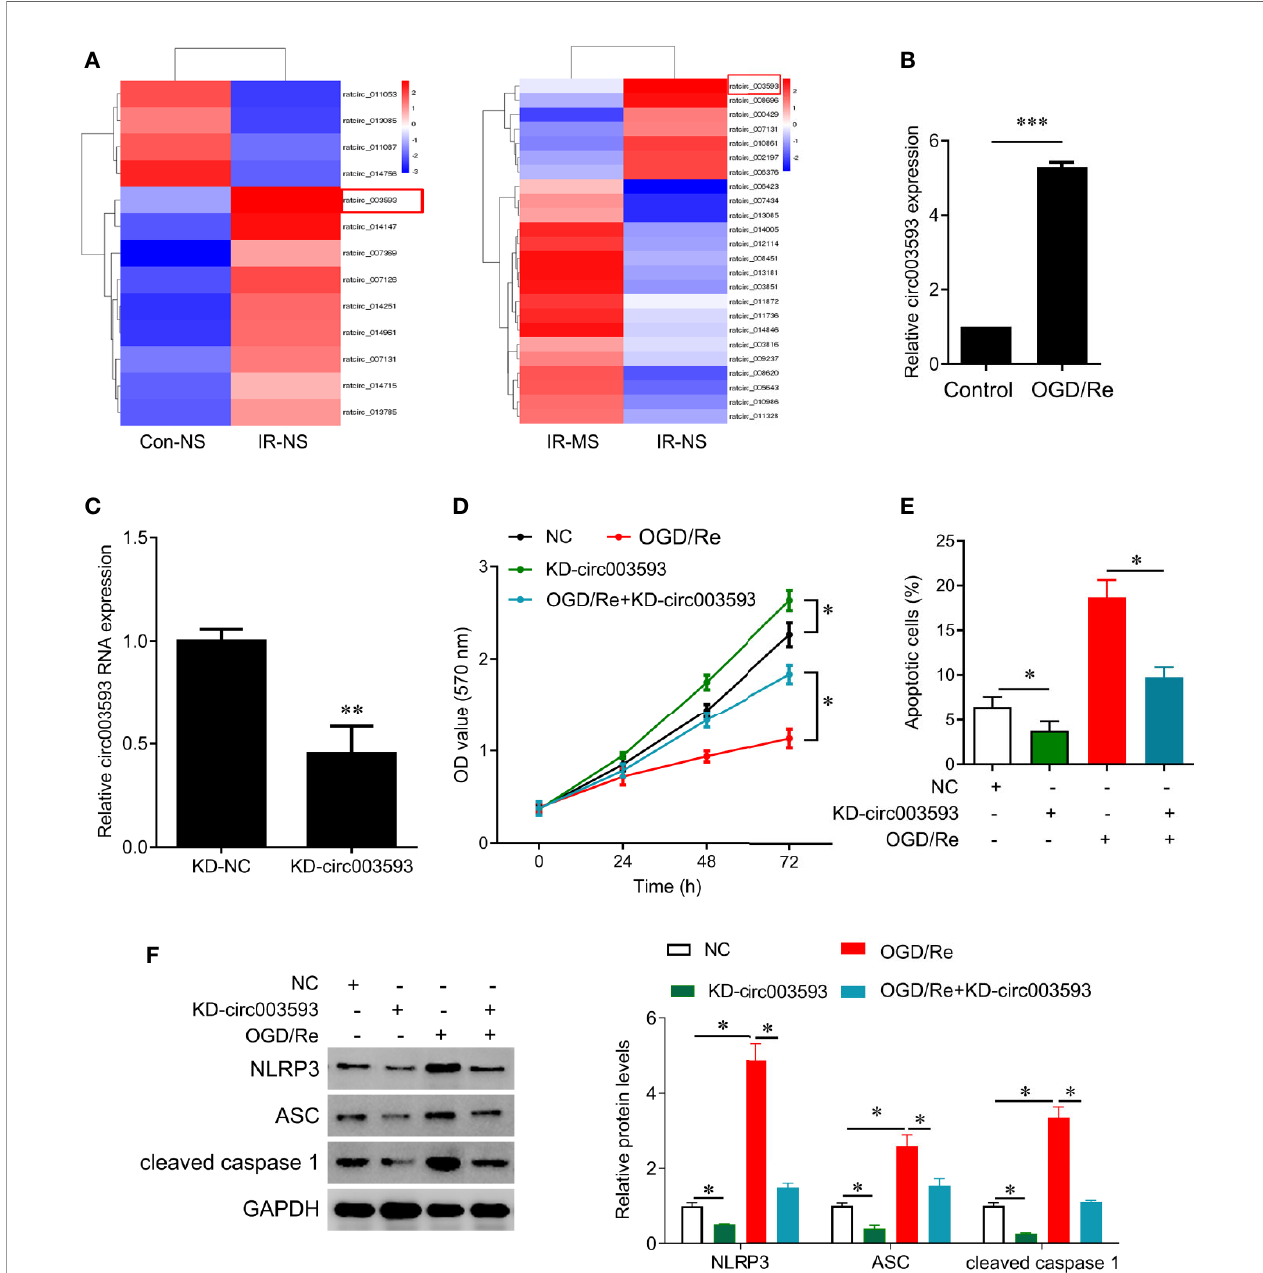
FIGURE 5 | The effects of Malva sylvestris L. on circular RNA expression. (A) cirRNA expression pro fi les in I/R rat model with or without MS pre-treatment. (B) qPCR was performed to measure the expression of circ_003593 in H9c2 cells after OGD/Re treatment. (C) circ_003593 was knocked down by shRNA transfection. (D) CCK-8 was performed to determine the cell viability in H9c2 cells after indicated treatment. (E) Flow cytometry was performed to determine the apoptotic cell in H9c2 cells after indicated treatment. (F) Western blot was performed to determine the expression of NLRP3, ASC, and cleaved caspase 1 in H9c2 cells after indicated treatment. *p < 0.05, **p < 0.01, and ***p < 0.001. MS, Malva sylvestris L.; NS, normal saline; I/R, ischemia-reperfusion; KD, knockdown; OGD/ Re, oxygen glucose deprivation/reoxygenation; ASC, adapter apoptosis-associated speck-like protein containing a C-terminal caspase recruitment